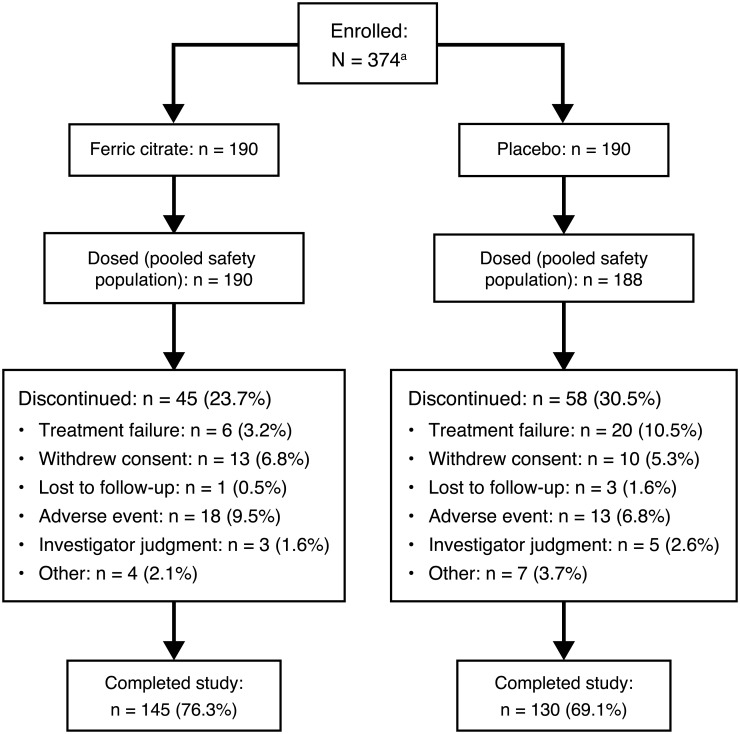
CONSORT diagram.aNine patients were enrolled in both studies; of these, three were randomized to the same treatment in both trials and only their data from the phase 3 trial were included, and six patients who were randomized to different treatments contributed data from each trial but were only counted once in the total number of enrolled subjects.